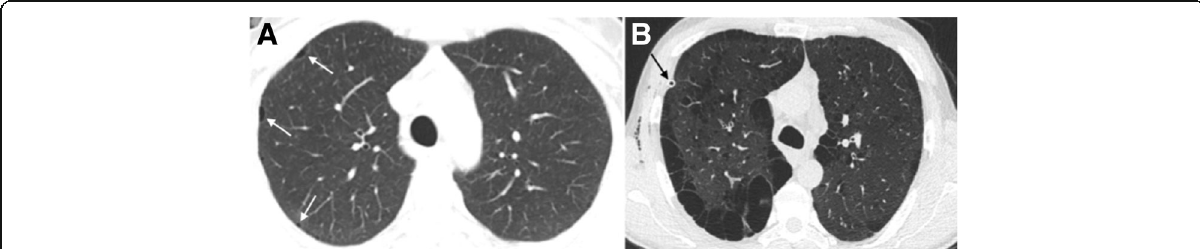
Fig. 7 Subtypes of PSE according to the Fleischner Society guidelines on HRCT. a Axial CT shows mild PSE (white arrows) with up to 1 cm juxtapleural well-demarcated lucencies. b Axial CT depicts substantial PSE, defined as cyst-like lucencies or bullae greater than 1 cm adjacent to the pleura. The patient had spontaneous pneumothorax and black arrow depicts a chest drain. Subcutaneous emphysema is also visible in the right thoracic wall